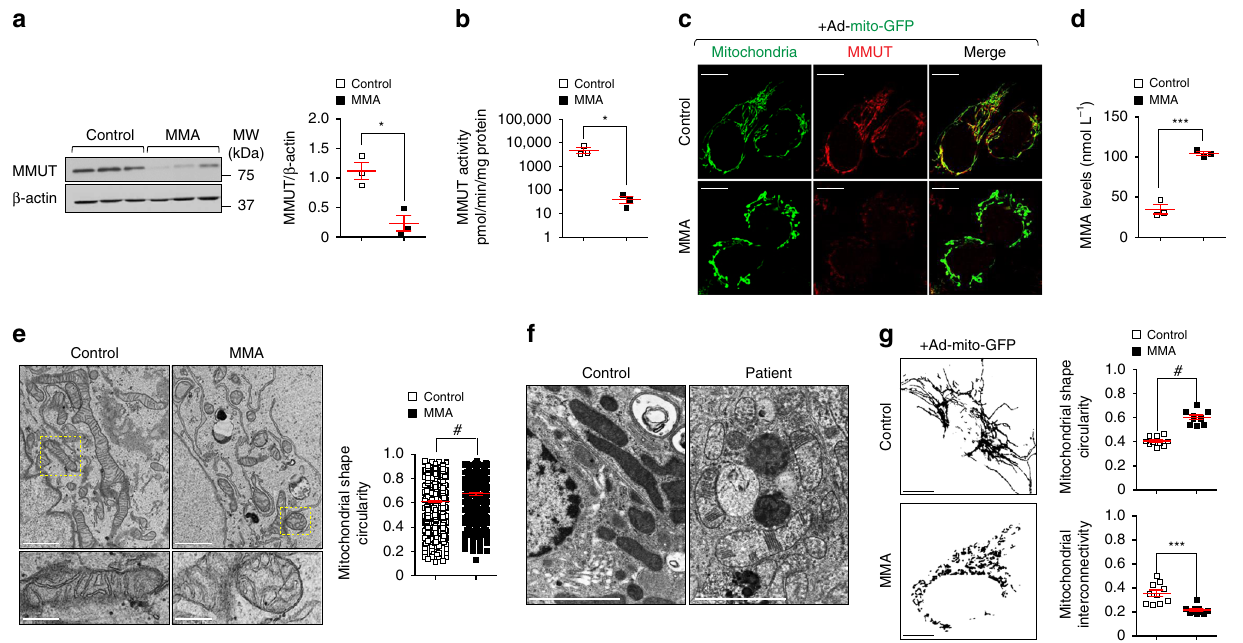
Fig. 1 Abnormal mitochondrial network in MMA kidney cells. a Immunoblotting and quanti fi cation of MMUT and b its enzyme activity in control and MMA kidney cells, n = 3 biologically independent experiments. β -actin was used as a loading control. c , g Cells were transduced with adenoviral particles carrying the mitochondrially targeted green fl uorescent protein (Ad-mito-GFP, green). c After 24 h post-transduction, the cells were immunostained for MMUT (red) and imaged by confocal microscopy. Yellow indicates the colocalization. d Quanti fi cation of methylmalonic acid (MMA) levels by liquid chromatography tandem mass spectrometry (LC-MS/MS, n = 3 biologically independent samples). e Representative electron micrographs and quanti fi cation of the shape (expressed as circularity) of the mitochondrial network in control and MMA cells; n = 527 mitochondria pooled from 24 control cells and n = 310 mitochondria pooled from 20 MMA cells. Values are pooled from two biologically independent experiments. Dotted yellow squares represent regions of the respective panels magni fi ed. f Representative electron micrographs showing the mitochondrial network in kidney biopsies from an individual healthy control subject and a patient with MMA. g Representative inverted images (left) and quanti fi cation of shape (expressed as circularity, top right) or interconnectivity (bottom right) of the mitochondrial network in control and MMA cells; each point representing the average values for circularity or interconnectivity in a cell, n = 10 cells per each condition pooled from two biologically independent experiments. Plots represent mean ± SEM. Two-tailed Student ’ s t -test, * P < 0.05, *** P < 0.001 and # P < 0.0001 relative to control cells. Scale bars are 10 μ m in c and g , and 1 μ m (top) and 250 nm (bottom) in e and 2 μ m in f . Unprocessed scans of original blots are shown in Supplementary Fig. 13. Source data are provided as a Source Data fi